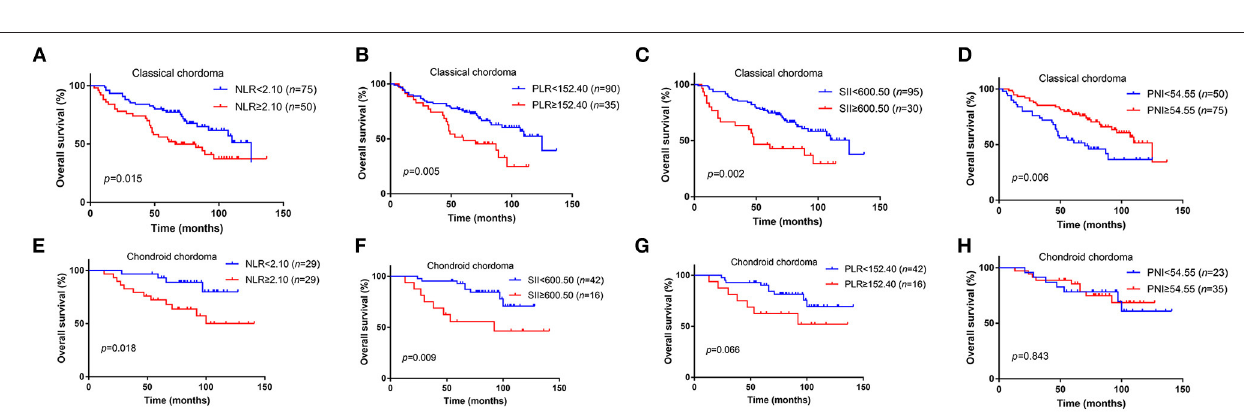
FIGURE 2 | Kaplan–Meier survival curves of NLR, PLR, SII, and PNI for OS in different pathological types of chordoma. (A) High NLR was associated with poor OS in classical chordoma ( p = 0.015). (B) High PLR was associated with poor OS in classical chordoma ( p = 0.005). (C) High SII was associated with poor OS in classical chordoma ( p = 0.002). (D) Low PNI was associated with poor OS in classical chordoma ( p = 0.006). (E) High NLR was associated with poor OS in chondroid chordoma ( p = 0.018). (F) High SII was associated with poor OS in chondroid chordoma ( p = 0.009). (G) No significant association was observed between PLR and OS in chondroid chordoma ( p = 0.066). (H) No significant association was observed between PNI and OS in chondroid chordoma ( p = 0.843). NLR, neutrophil lymphocyte ratio; PLR, platelet lymphocyte ratio; SII, systemic immune-inflammation index; PNI, prognostic nutritional index; OS, overall